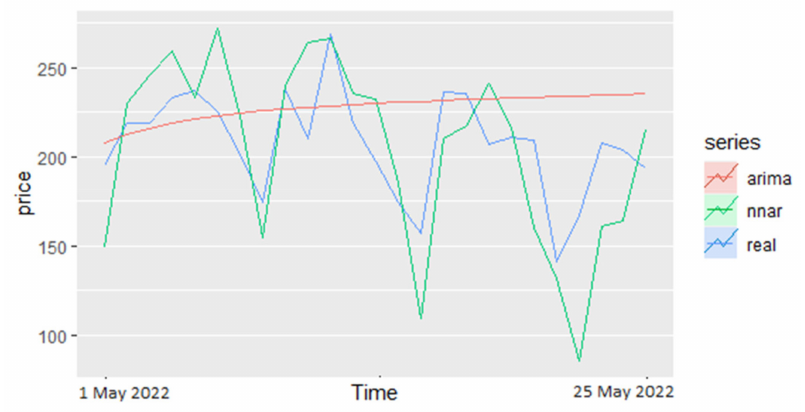
Figure 5. Price forecast comparison–ARIMA, NNAR, and real